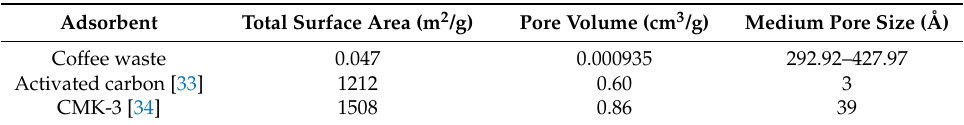
Table 1. Total surface area ( S t ), pore volume ( V p ), and medium pore size ( R m ) of coffee waste from A company and activated